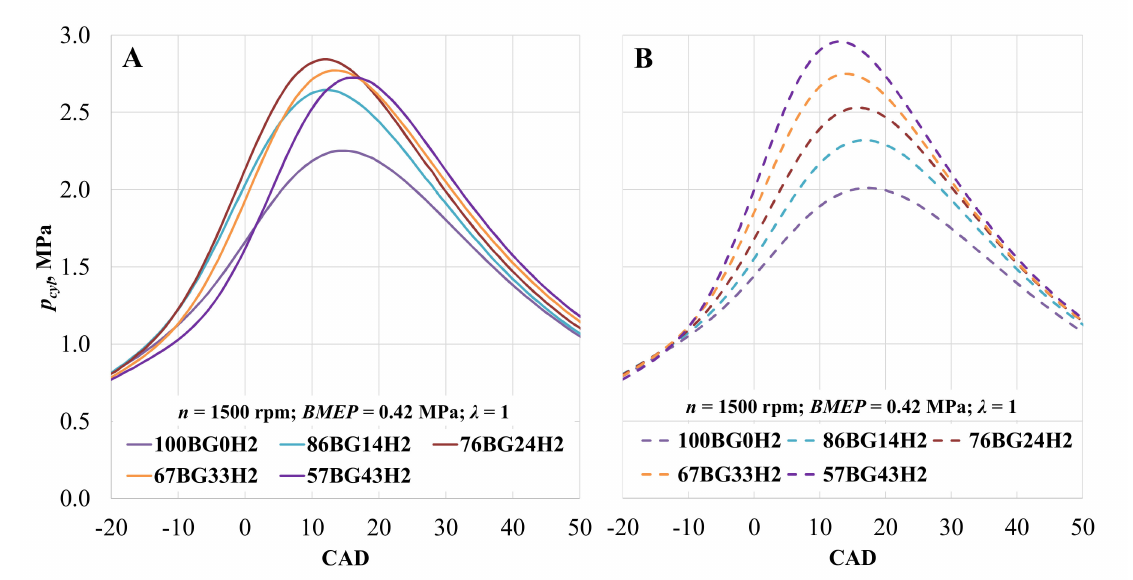
Figure 6. Pressure in the cylinder (p cyl ) depending on hydrogen concentration. ( A )—with optimal ST for the mixture; ( B )—with optimal CNG